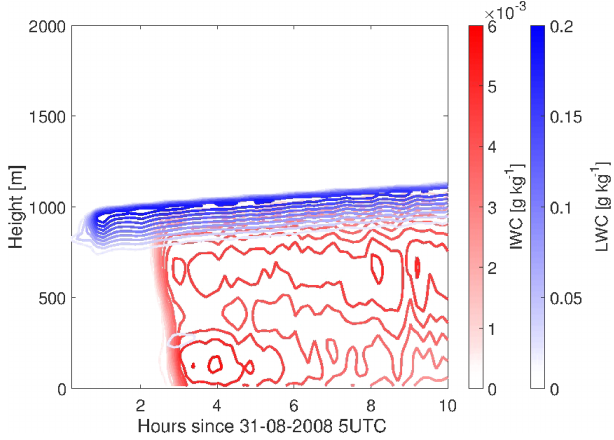
Figure 11. Mean values of LWC (blue) and IWC (red) of the Sen- sIce simulation with an ice crystal concentration value of 1L − 1 .